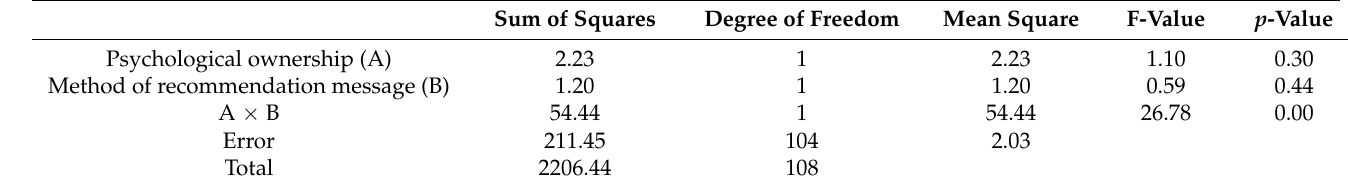
Table 3. Result of ANOVA